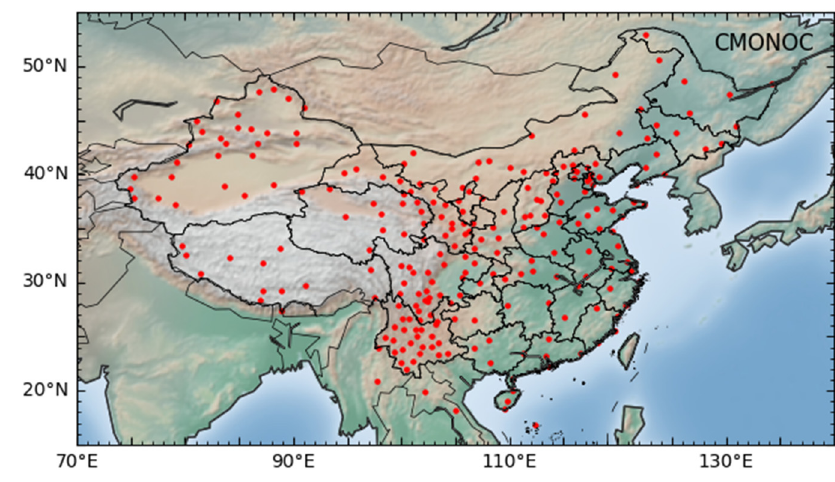
Figure 3. Geographical distribution of CMONOC GNSS stations.